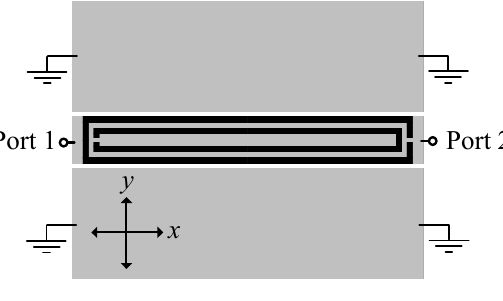
Figure 1. Typical topology of an angular or linear displacement sensor consisting of a CPW transmission line loaded with an SRR (in black) etched in the back side of the substrate. A rectangular shaped SRR is etched just below the central strip of the CPW to improve the sensitivity